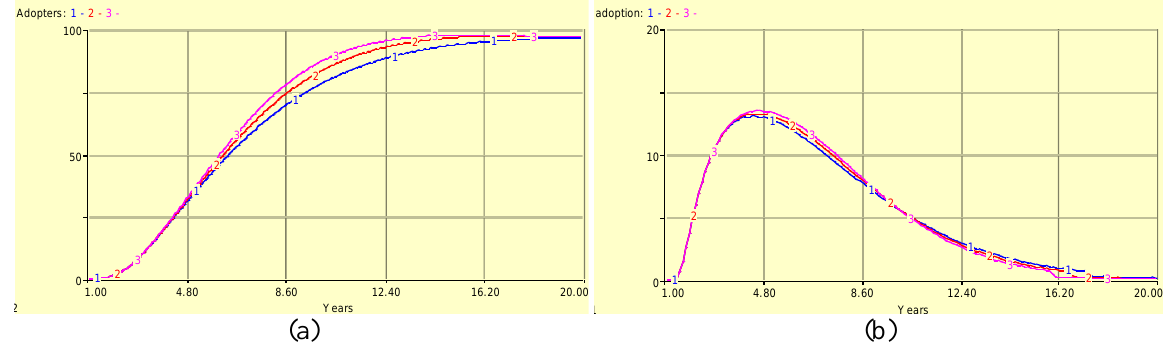
Fig. 4. Sensitivity analysis behaviour based on adoption fraction